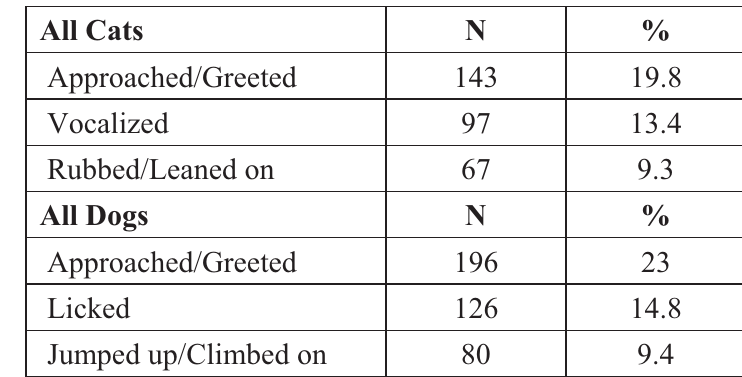
Table 3. Three most common responses to the question three: “What did this pet do when you first met